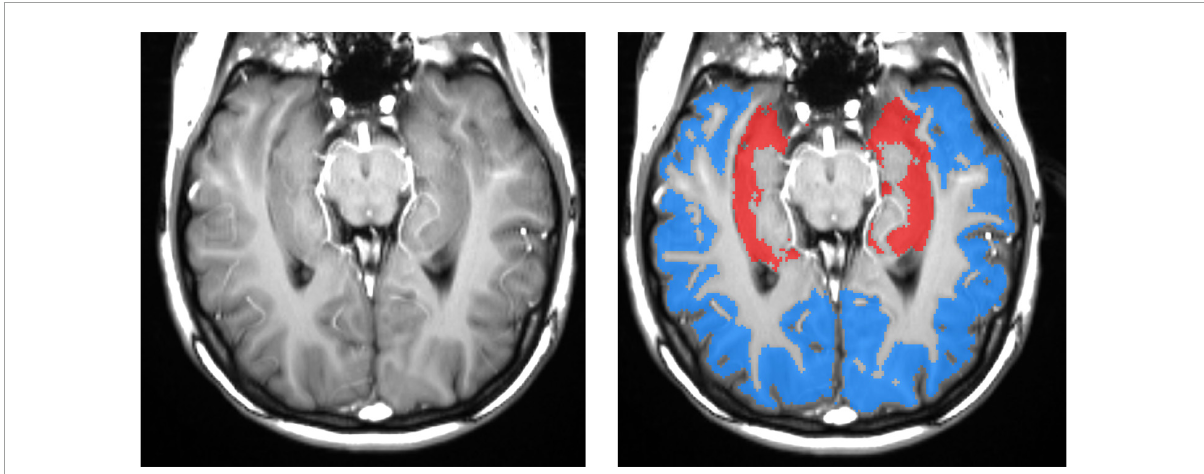
FIGURE2 Left panel: spatial resolution and tissue contrast on a tagged (labeled) oblique balanced steady-state free precession image through the main body of the hippocampus. The right panel shows segmented masks for hippocampal (red) and cortical (blue) gray matters. High-resolution ASL enables an accurate definition of hippocampal gray matter, which is important because gray matter CBF is two to three times greater than that in the white matter. Including a variable fraction of white matter would contaminate results with significant errors. The cortical ROI encompasses mostly the temporal and parietal and, in some cases, also occipital cortices on the same axial slice that included both